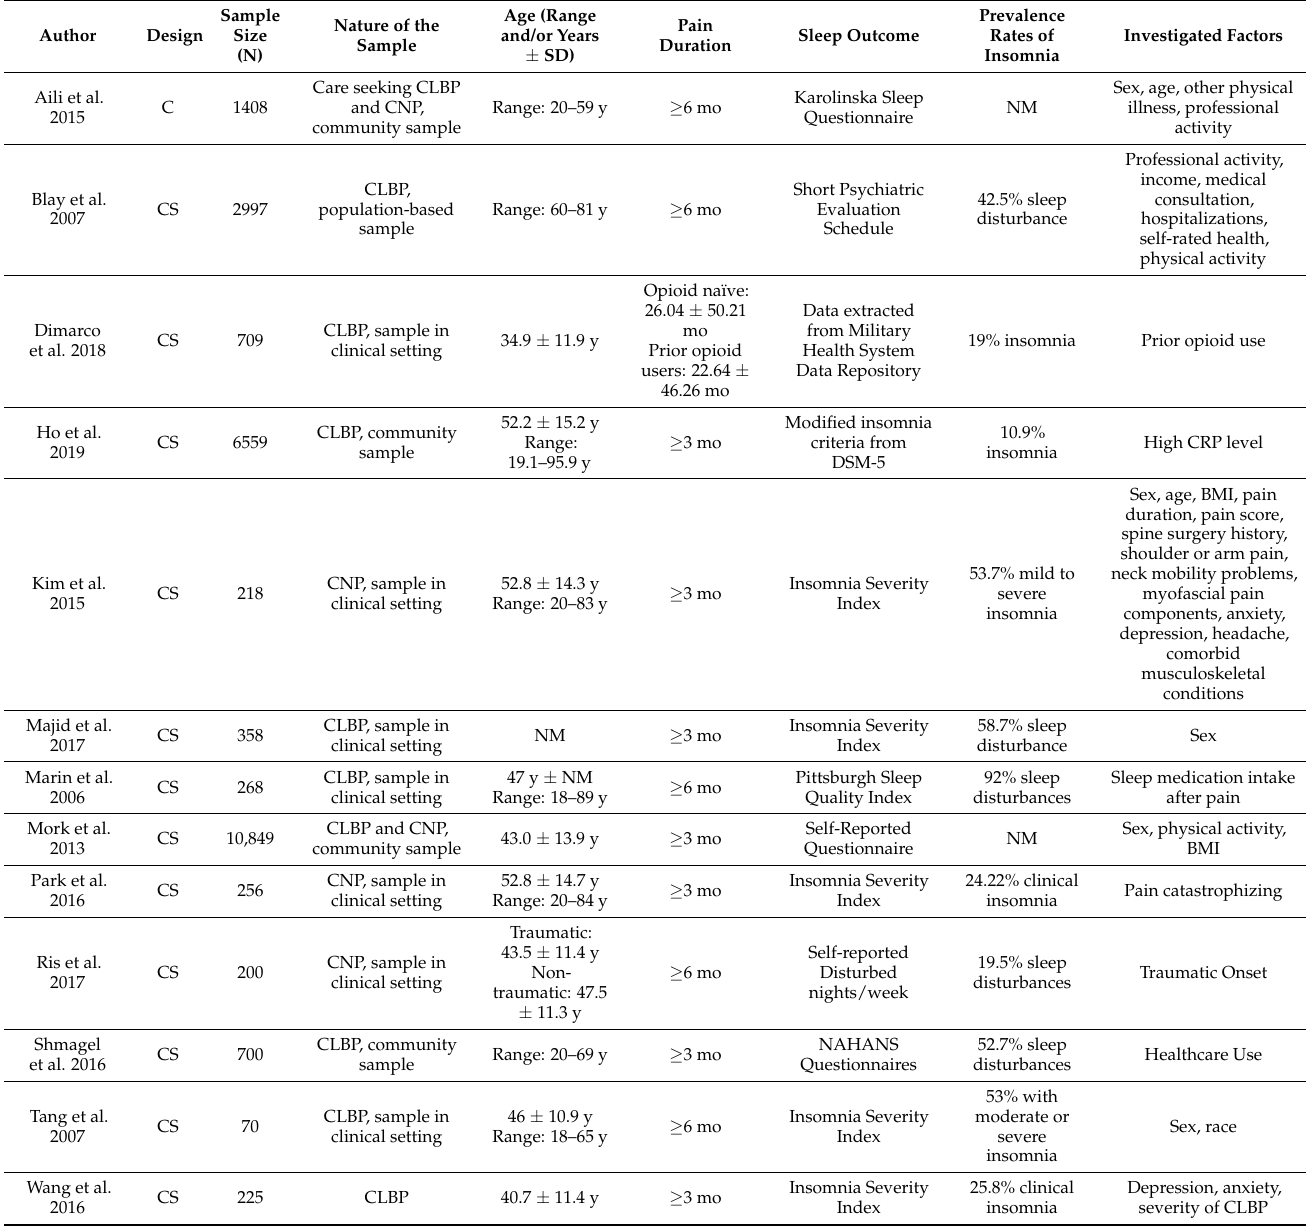
Table 1. Characteristics of the included